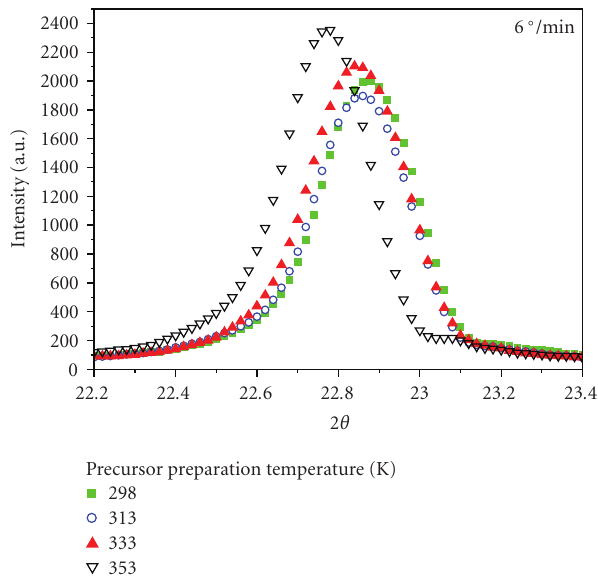
Figure 5: XRD patterns of the peak at 2 θ = 22 . 8 ◦ for NaTaO 3 powder synthesized at several precursor preparation